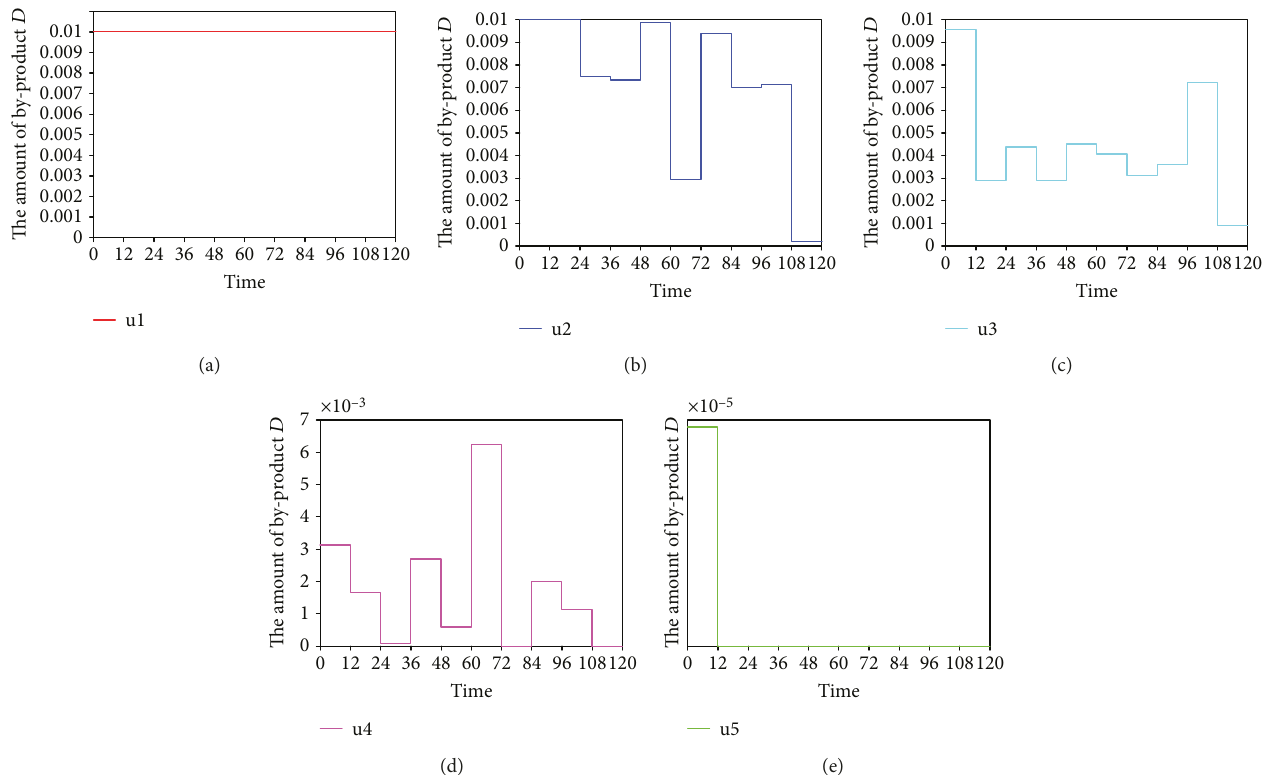
Figure 15: The Pareto optimal trajectories of fi ve selected solutions for case II. (a) u1, (b) u2, (c) u3, (d) u4, and (e) u5.